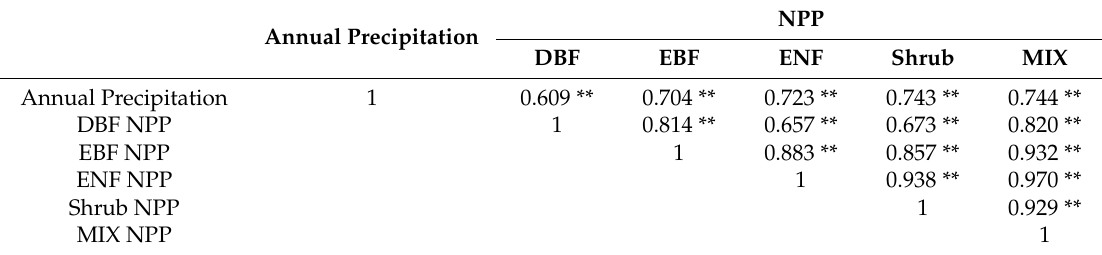
Table 8. Pearson correlation analysis between NPP of five forest types and annual precipitation in TGR. Annual Precipitation